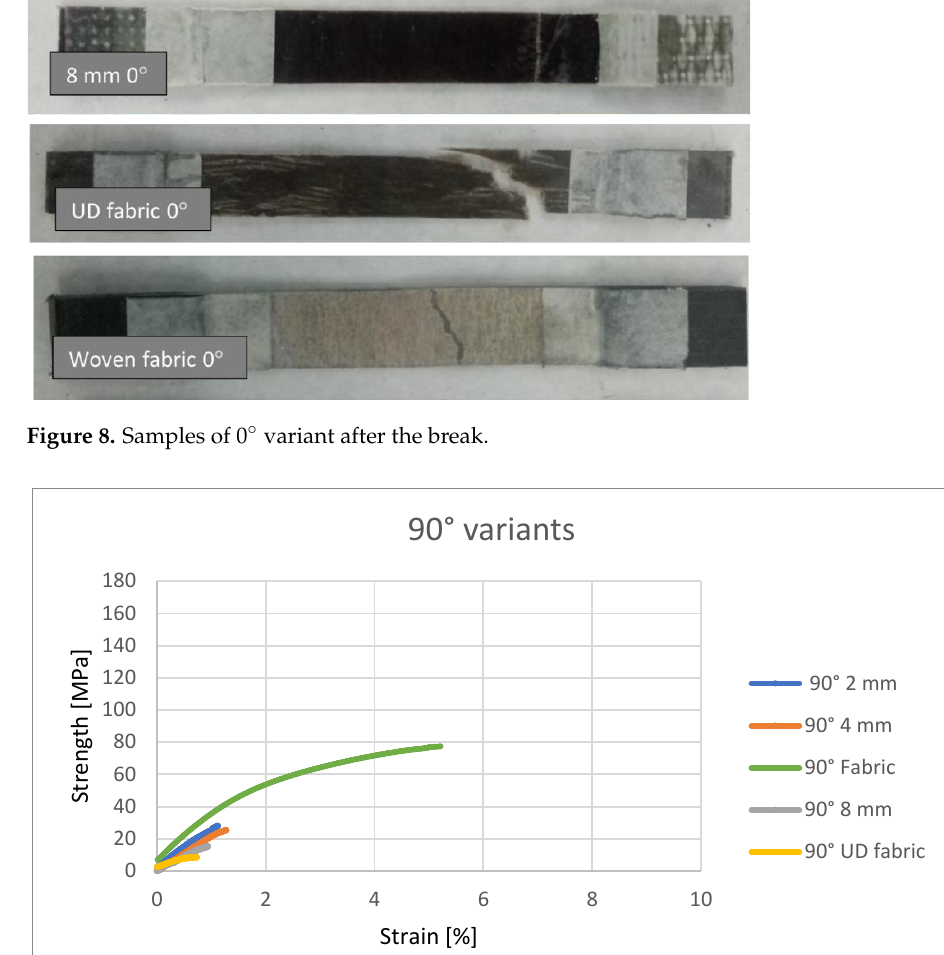
Figure 8. Samples of 0° variant after the break.